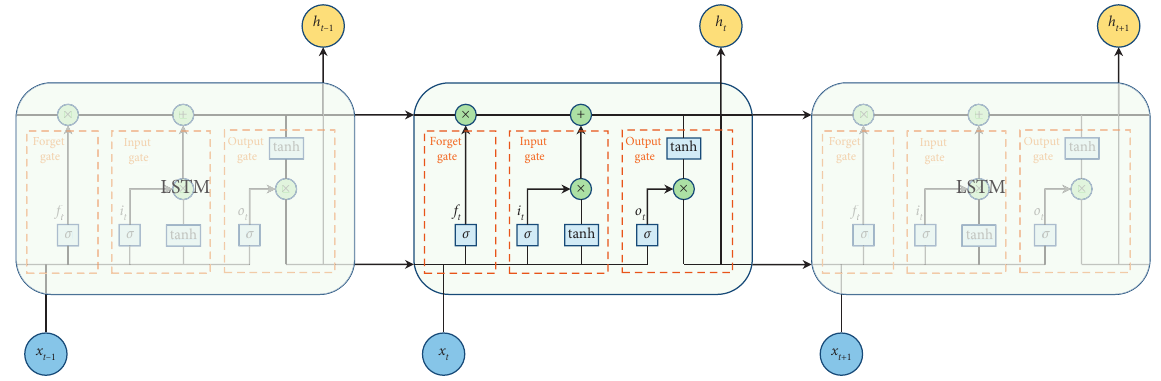
Figure 2: Architecture of LSTM